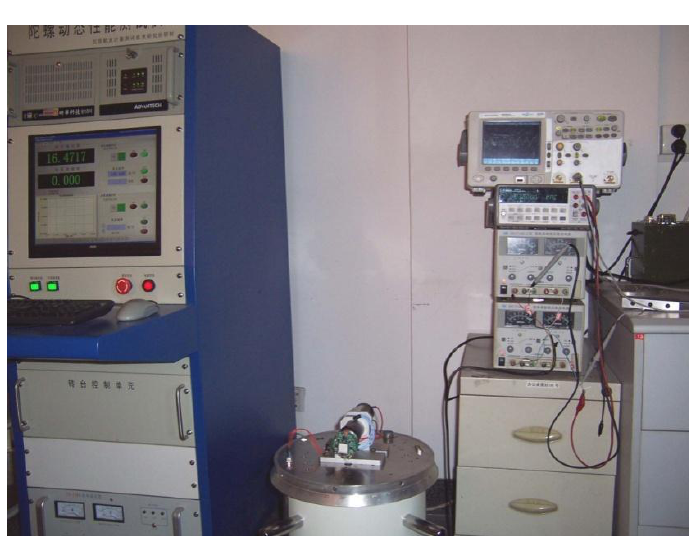
Figure 6. Experimental platform.